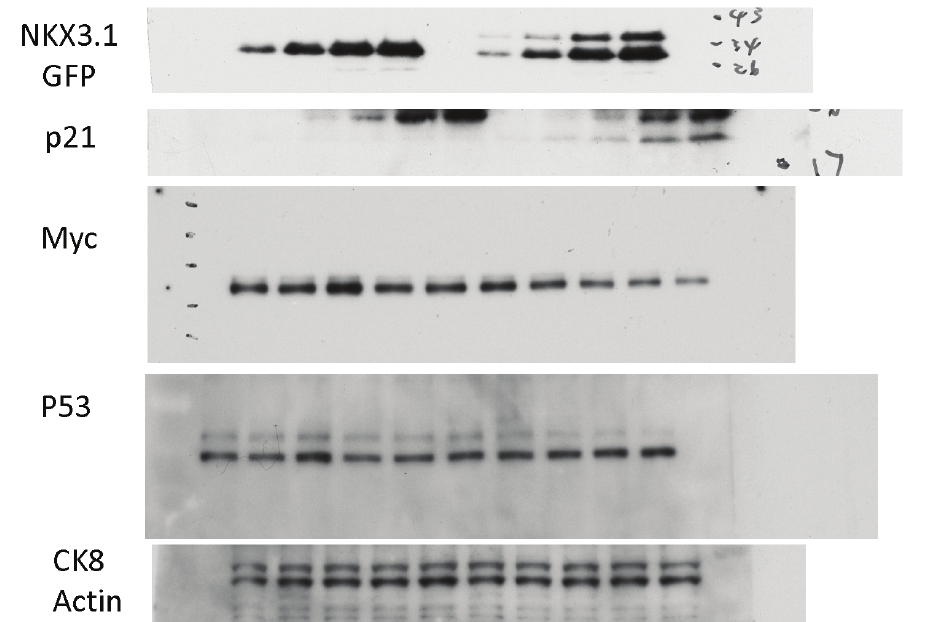
S1.Figure S8. Uncropped immunoblots for Figure